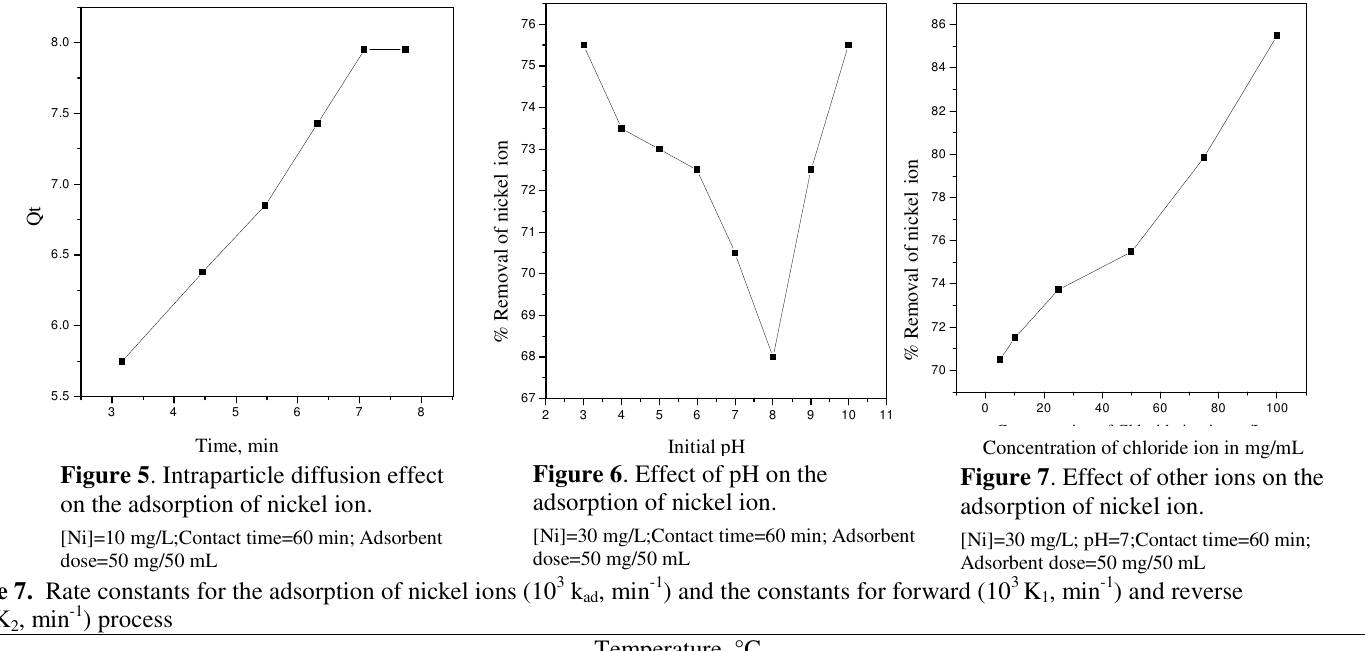
Figure 7 . Effect of other ions on the adsorption of nickel , min -1 ) and reverse 1